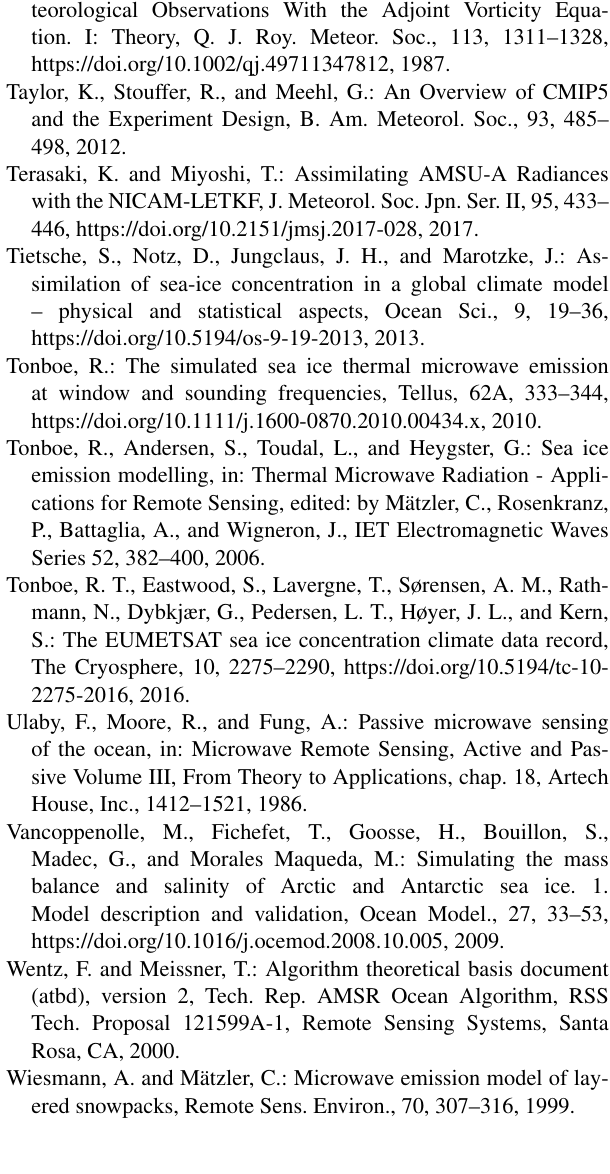
Figshare, https://doi.org/10.6084/m9.figshare.6626549.v6,